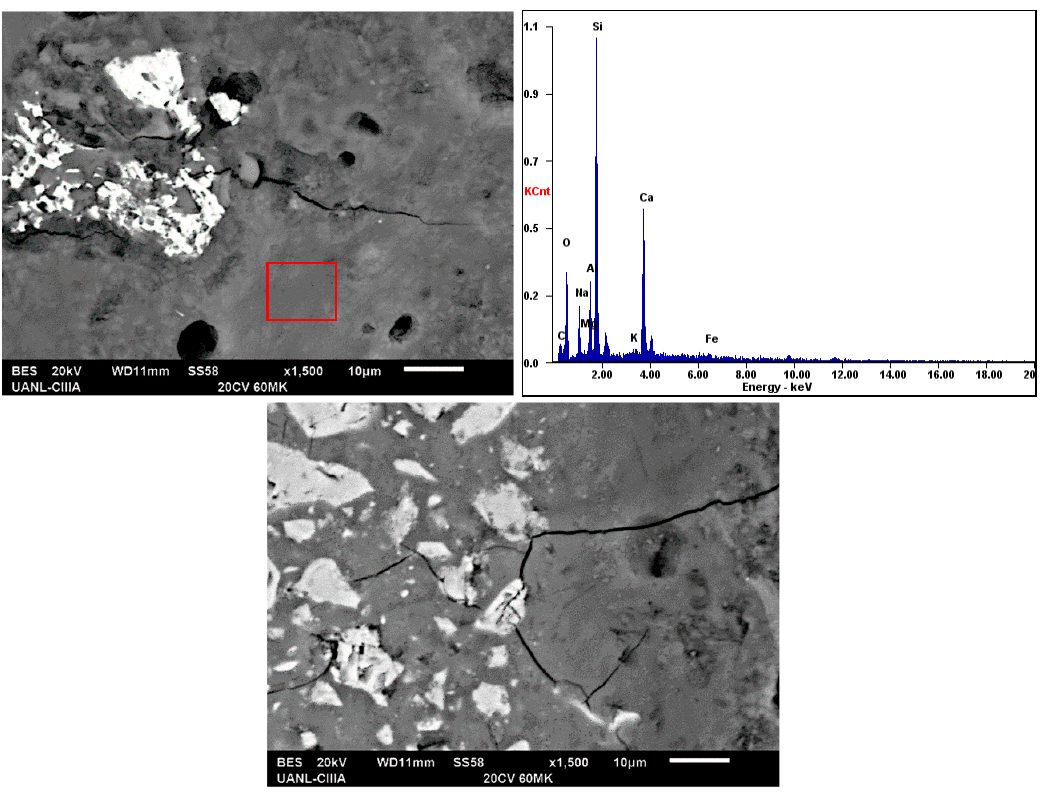
Materials 2020 , 13 , x FOR PEER REVIEW Figure 4. Micrographs of systems cured at 90 days with 16% Na 2 O as alkaline activator.